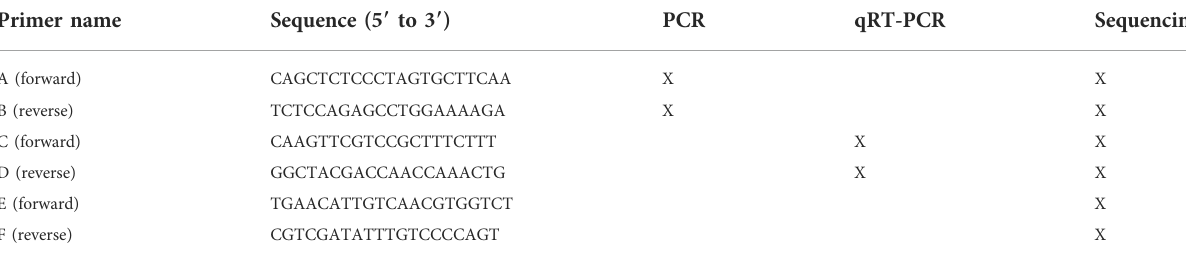
TABLE 1 Sets of speci fi c primers for the human P2RY4